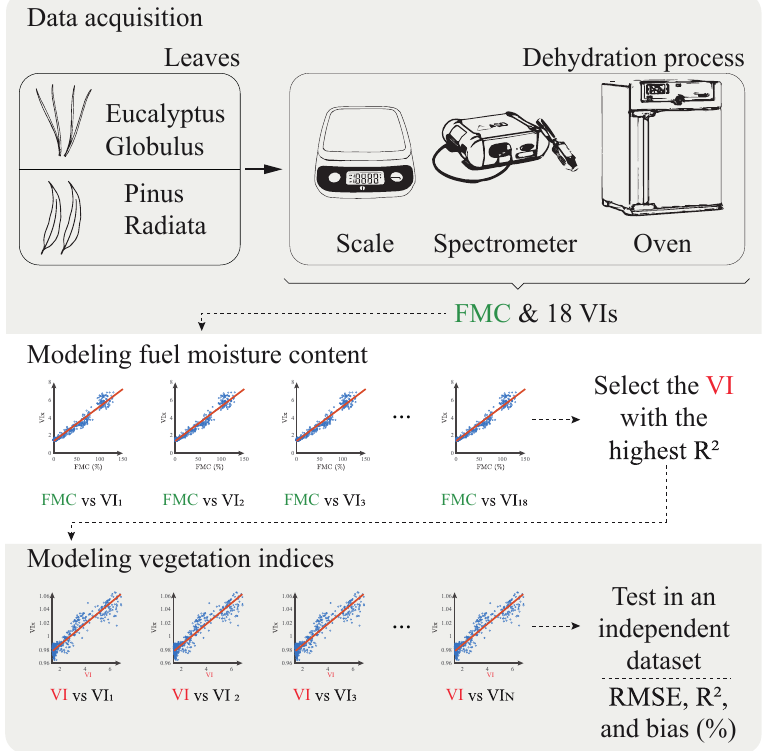
Figure 1. General scheme of the measurement and modeling process of the vegetation